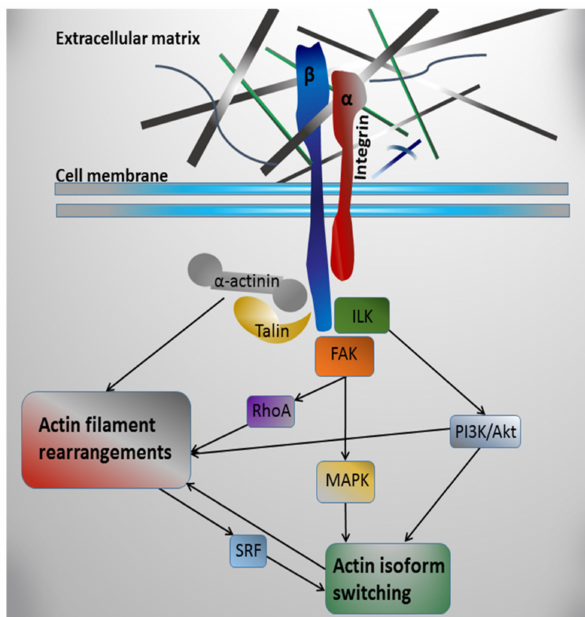
Figure 1. Schematic diagram summarizing the possible mechanisms for integrin-mediated regulation of actin filament rearrangements by extracellular matrix in